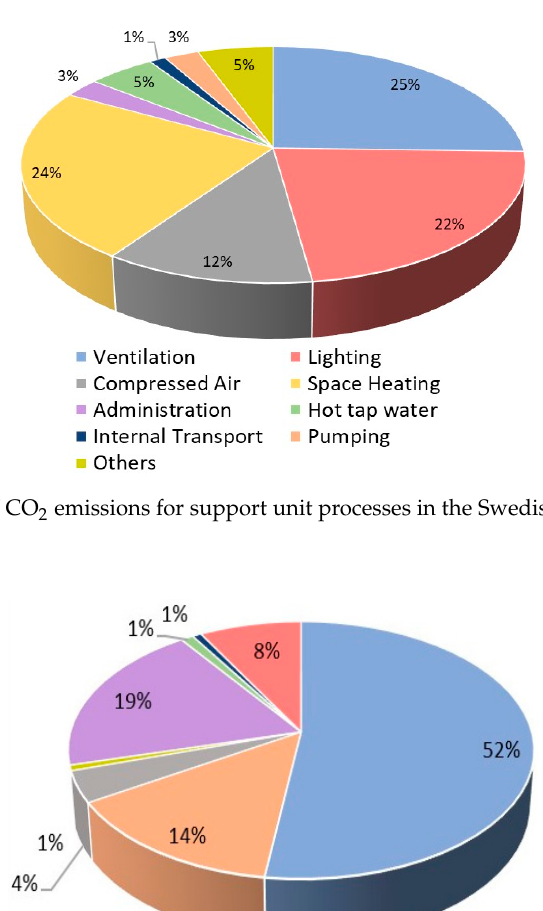
Figure 14. The share of CO 2 emissions for support unit processes in the Swedish engineering industry (Scenario 1).